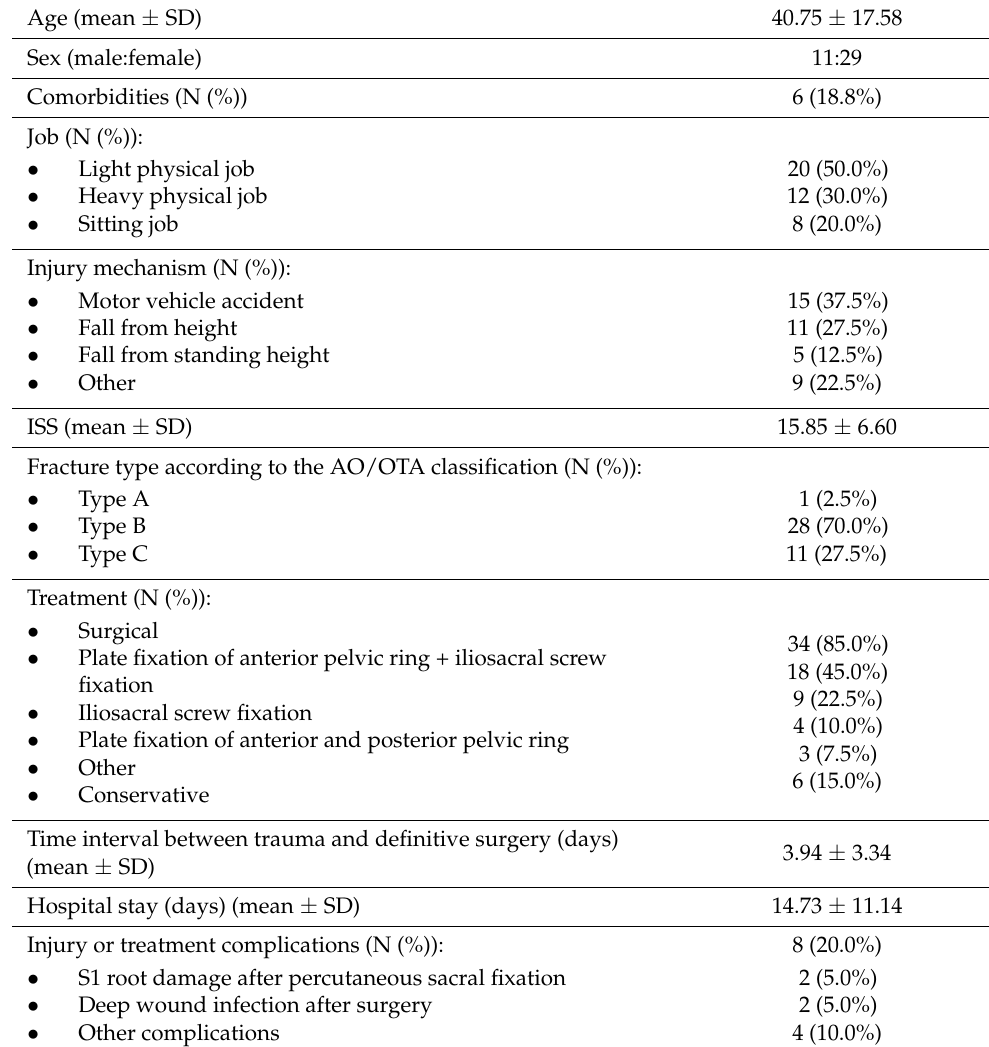
Table 1. Overall results of the Lithuanian version of the Majeed Pelvic Score, Lithuanian SF-36 Physical Component Summary (PCS), and the Iowa Pelvic Score between time-points. Data are presented as median (IQR).